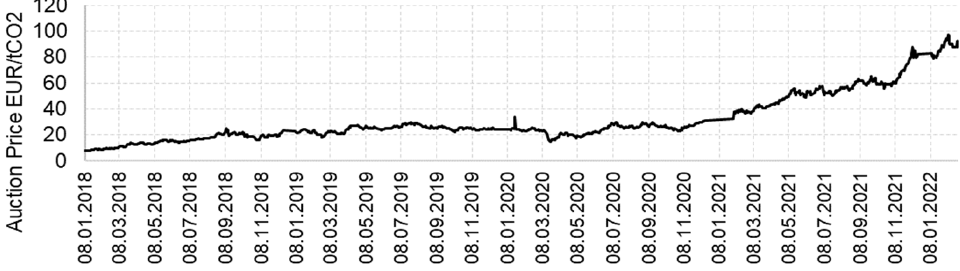
Figure A3. The market prices of CO 2 emission permit EUA (Carbon Emissions Allowances). Source: own elaboration based on [46].